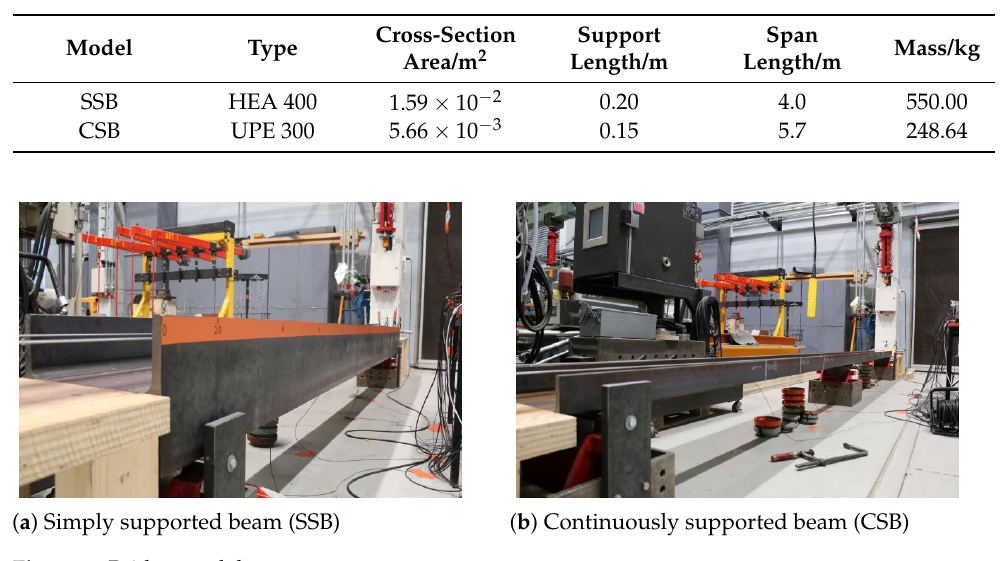
Figure 5. Bridge models.